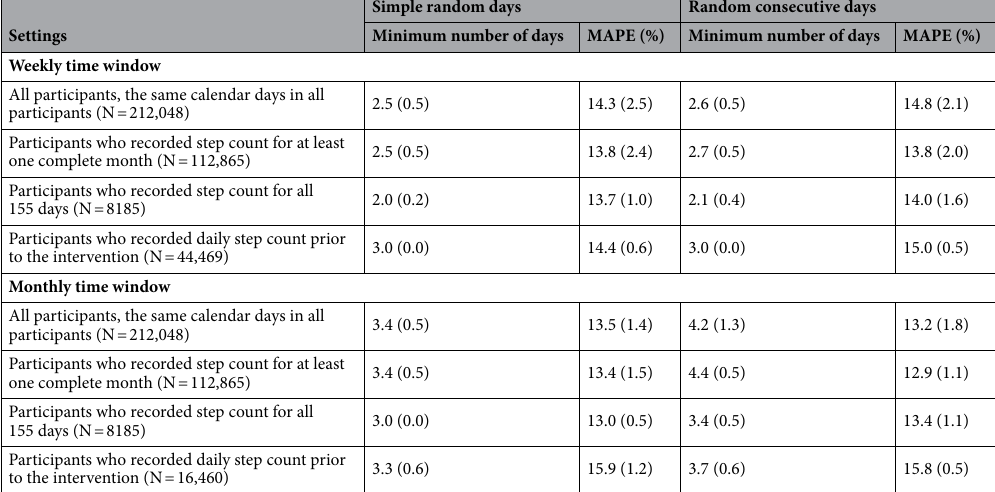
Table 4. Minimum number of days required for weekly and monthly level of daily step count with ICC ≥ 80% and the corresponding MAPE, under different settings. Data are in mean (SD) of results over 22 separate weeks or five separate months. ICC intraclass correlation coefficients, MAPE mean absolute percentage